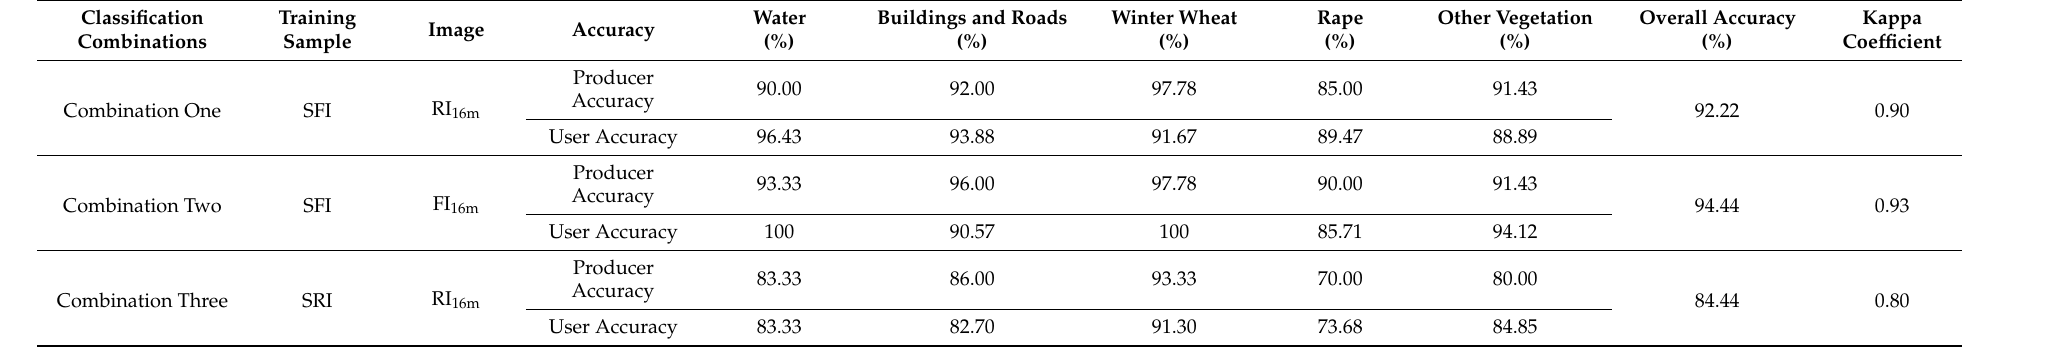
Table 6. Classification accuracy evaluation of different classification combinations of training samples and